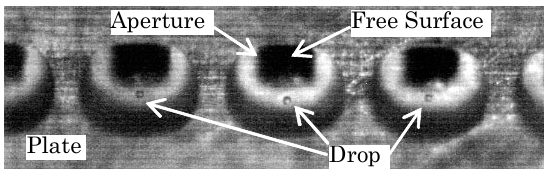
Plate Drop Fig.19 Drop Ejection by Print Head with Aperture Plate